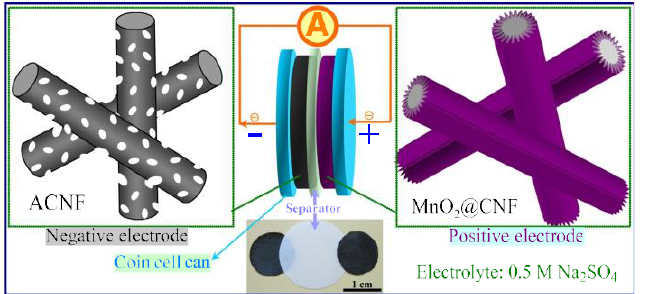
Figure 8. Illustration of the as-assembled asymmetric supercapacitor cell with MnO 2 /CNF compo- site as positive electrode and ACNF as a negative electrode in mild Na 2 SO 4 aqueous electrolyte. Reproduced with permission from [81]. Copyright © 2013, Elsevier Ltd. Reproduced with permission from [81]. Copyright ©2013, Elsevier